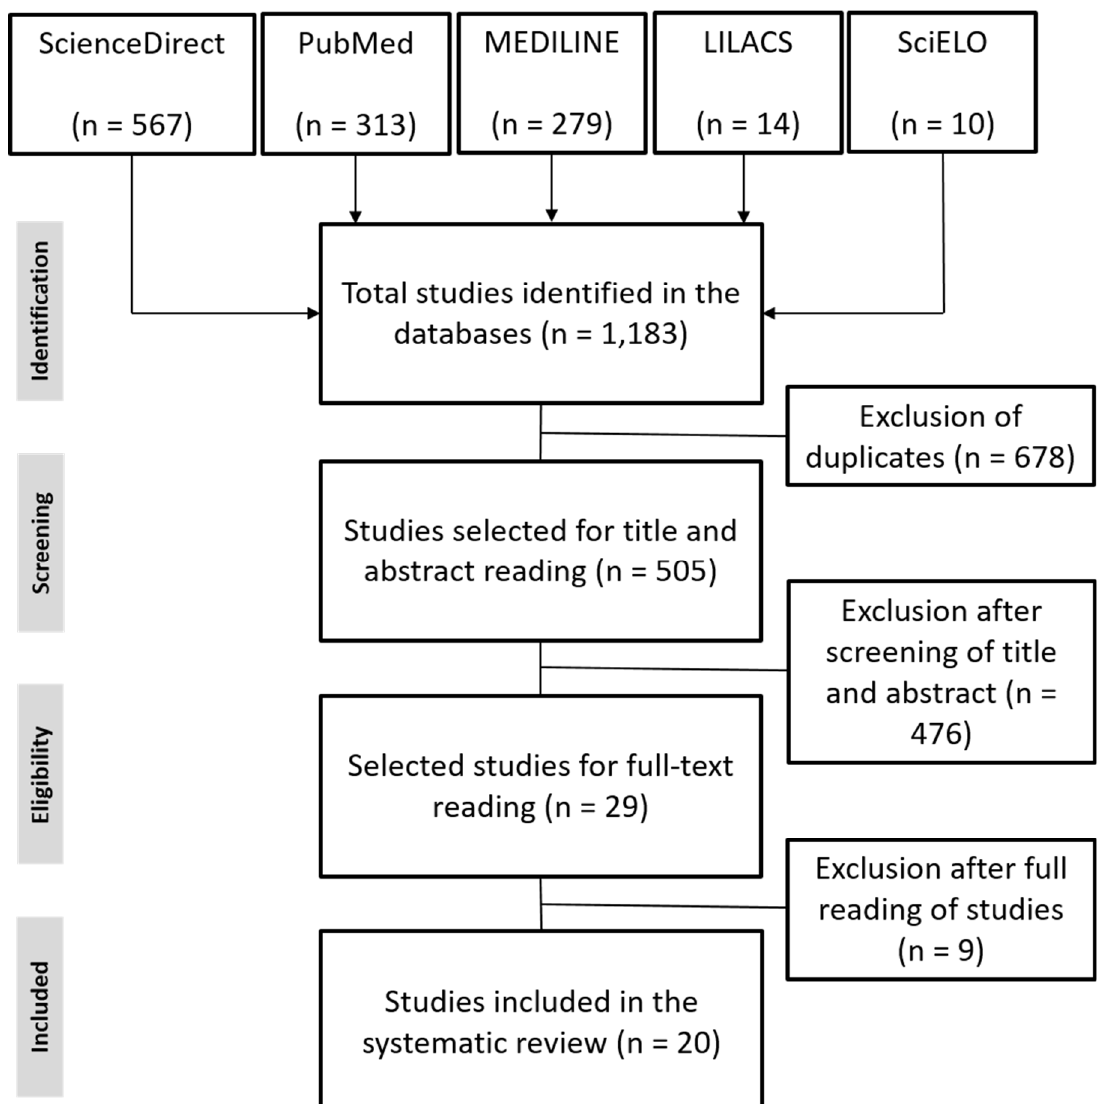
Figure 1. Flowchart based on the PRISMA protocol on evidence selection. The 20 studies were carried out in several countries on six different continents: South Initially, a meta-analysis with the general data was performed, and a combined seropos- America ( n = 6), Europe ( n = 3), Oceania ( n = 4), Asia ( n = 4), North America ( n = 2) and itivity of 21.95% (95% CI = 16.65–28.37%) was found, but with the presence of heterogeneity Africa ( n = 1), and the main information and data used to perform the meta-analysis of the identified by the Cochran Q test ( p < 0.01) and classified as high heterogeneity by the seropositivity of swine in leptospirosis are shown in Table 1. Higgins and Thompson test (I2 = 99.45%) (Figure Table 1. Summary of the main characteristics of the 20 studies included in the meta-analysis of se- ropositivity of swine leptospirosis.